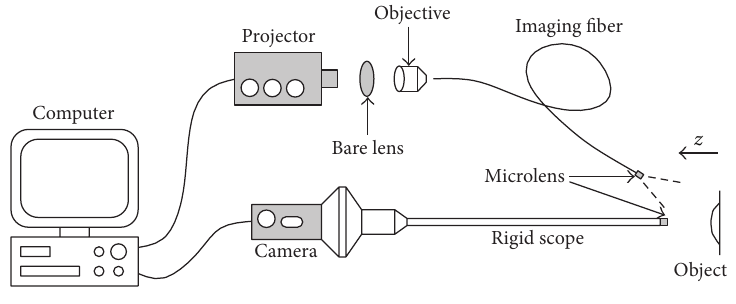
Figure 1: System